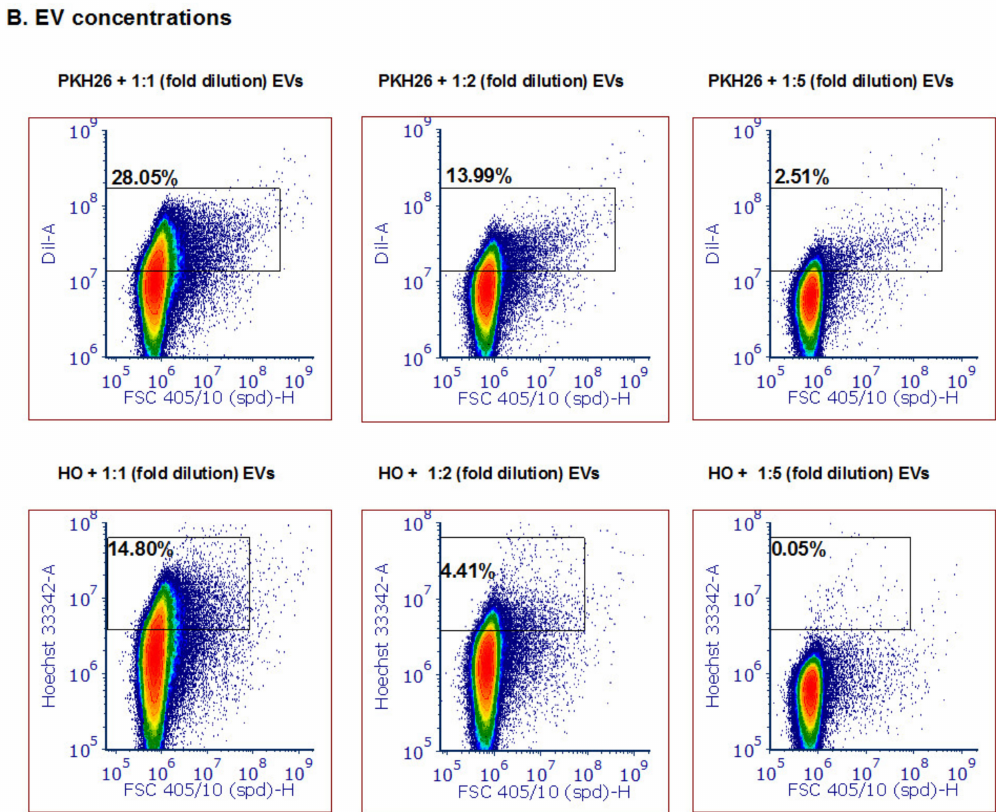
Figure 2. Detection of di ff erent types and amounts of Pf -derived EV cargo using the ZE5 analyzer. ( A ) Pf -derived EVs were stained using three di ff erent dyes to visualize di ff erent types of cargo components: proteins with the CFSE marker (top row), nucleic acids with the HO marker (middle row), and lipids with the PKH26 marker (bottom row). As controls, solutions containing free dye or unstained EVs were used. ( B ) Detection of di ff erent Pf -derived EV concentrations was achieved by diluting the EVs with the same dye (PKH26 and HO) amount. On the left: high concentration (8 × 10 11 par / mL); in the center and on the right: lower concentrations of